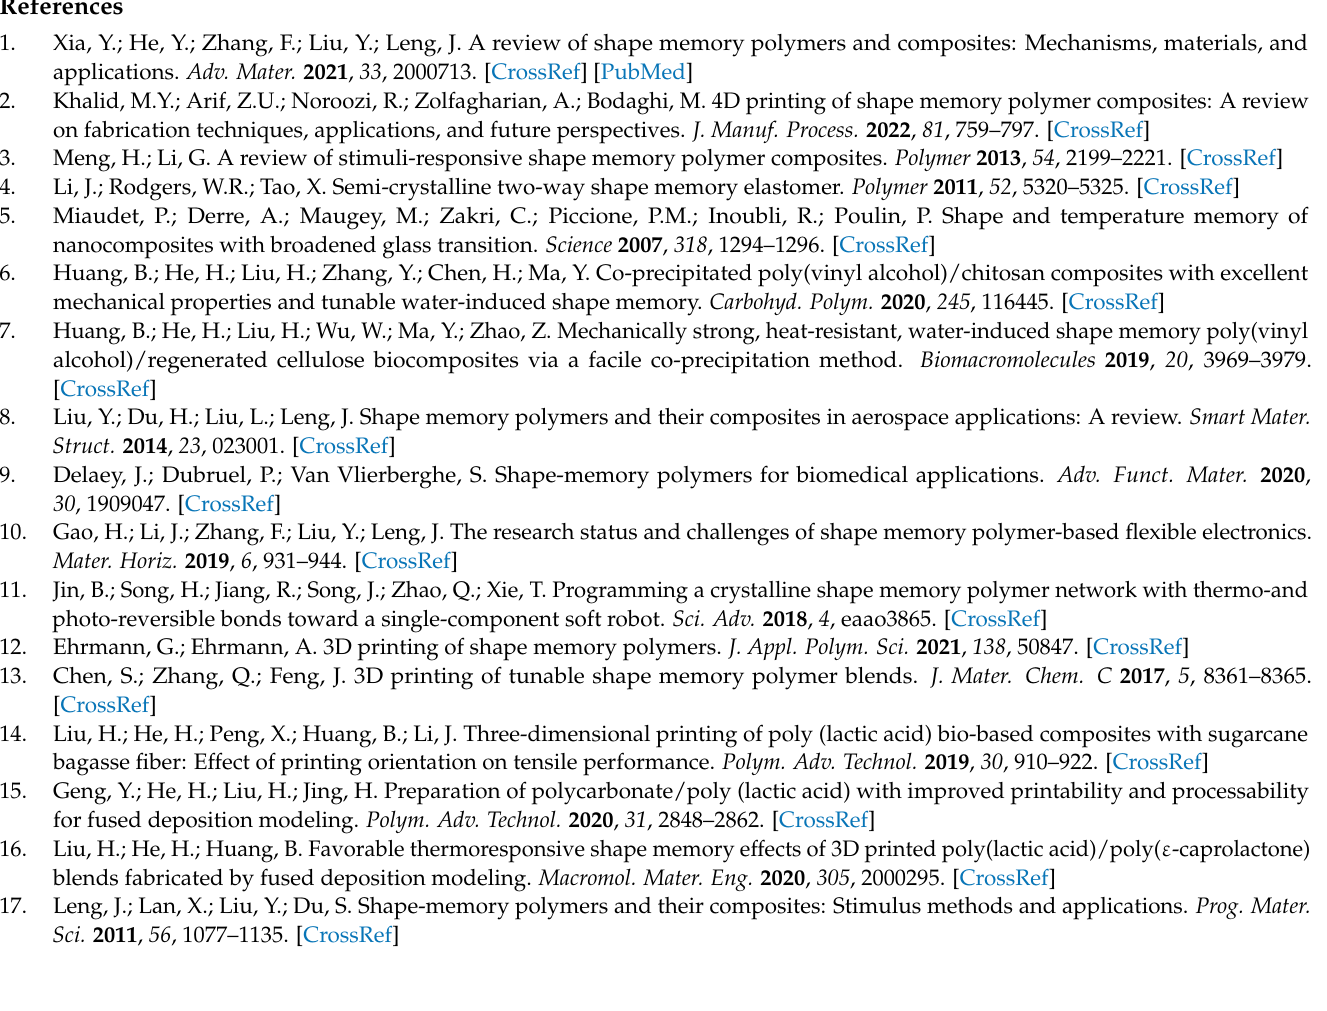
curves; Figure S3: FTIR spectra of the PLA/PCL blends modified with different PCL-NCO contents; Figure S4: Schematic dia-gram of action mechanism of the PCL-NCO in the PLA/PCL blend